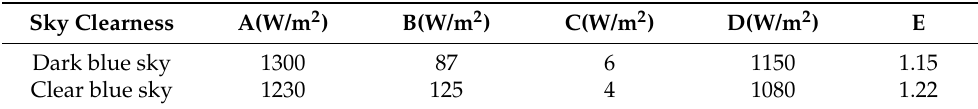
Table 3. Coefficients given by Perrin de